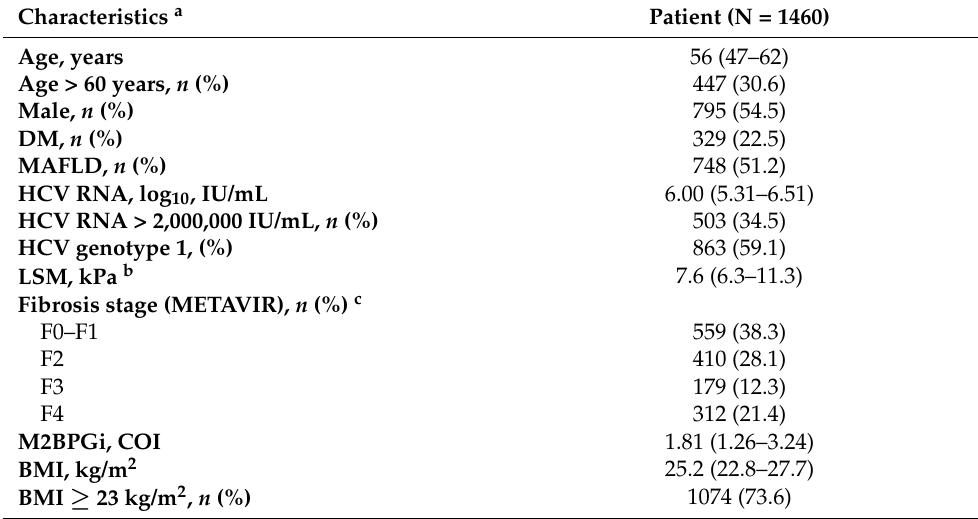
Table 1. Baseline patient characteristics.